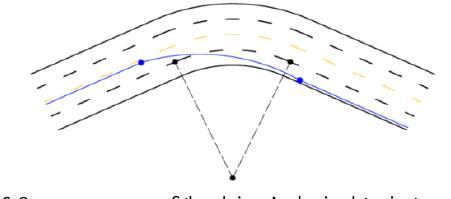
point is left behind. And the curvature is reduced.